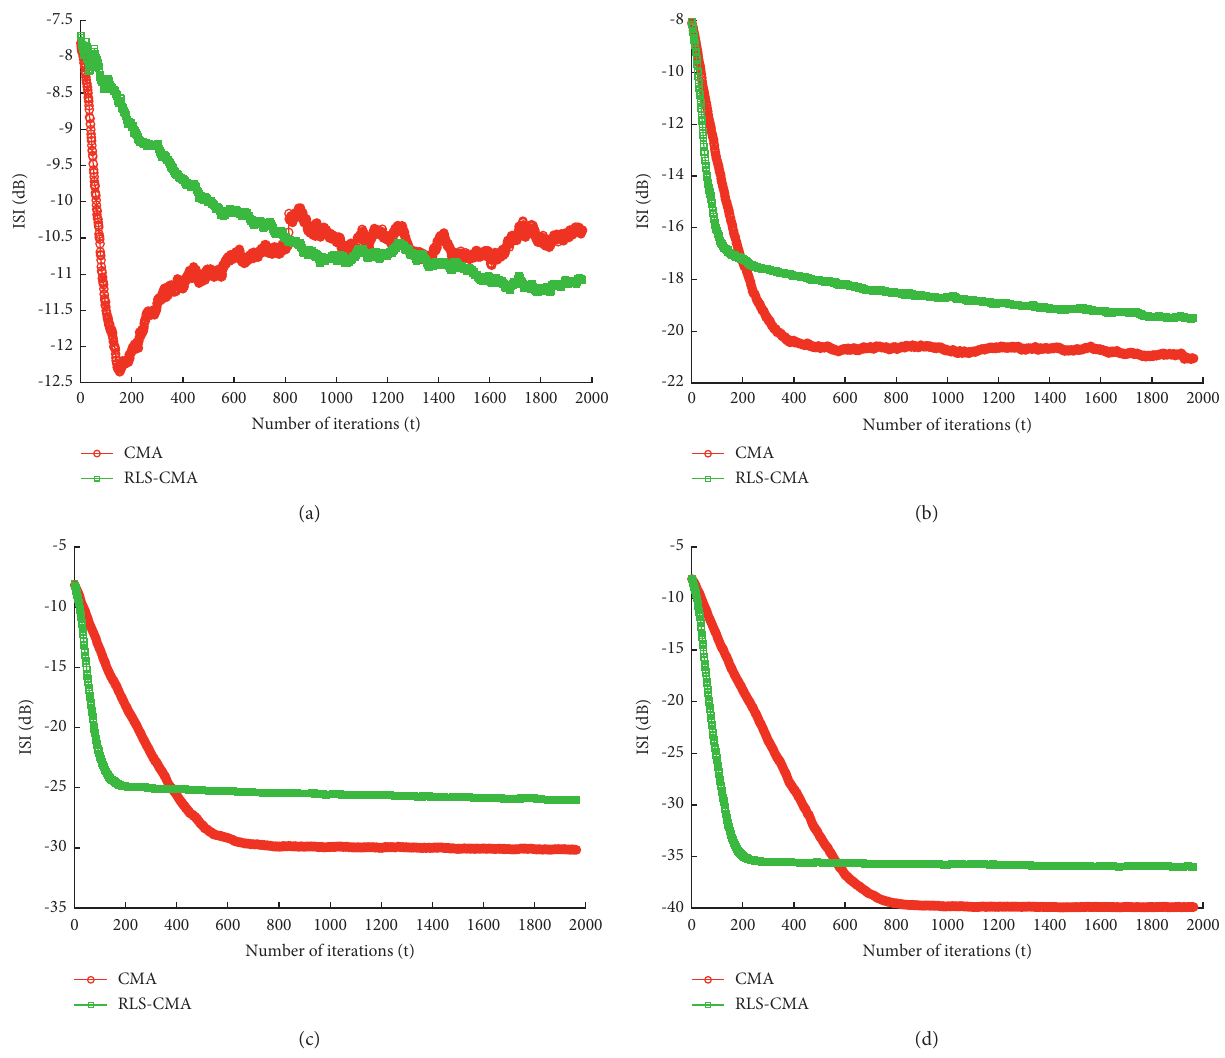
Figure 5: Relationships between the number of iterations and the ISI of the BPSK-modulated signal obtained for different blind equalisation algorithms. (a) SNR � 15dB. (b) SNR � 25dB. (c) SNR � 35dB. (d) SNR �